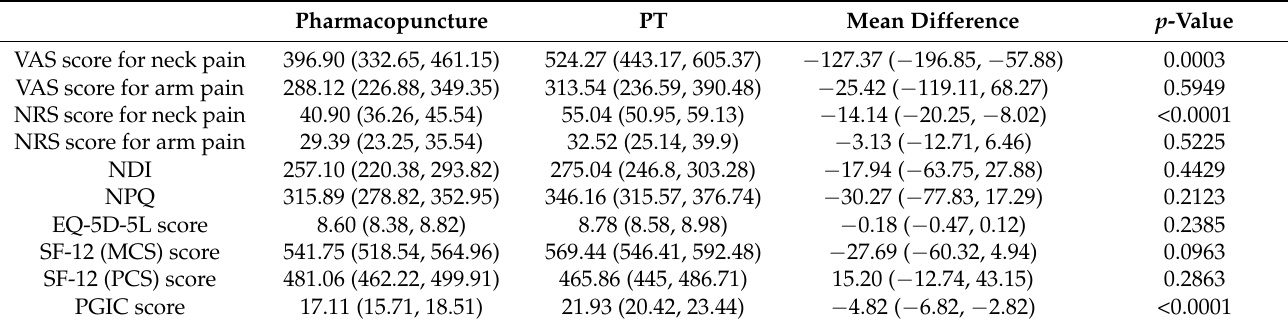
Table 3. Areas under the curves for the 12-week outcomes.